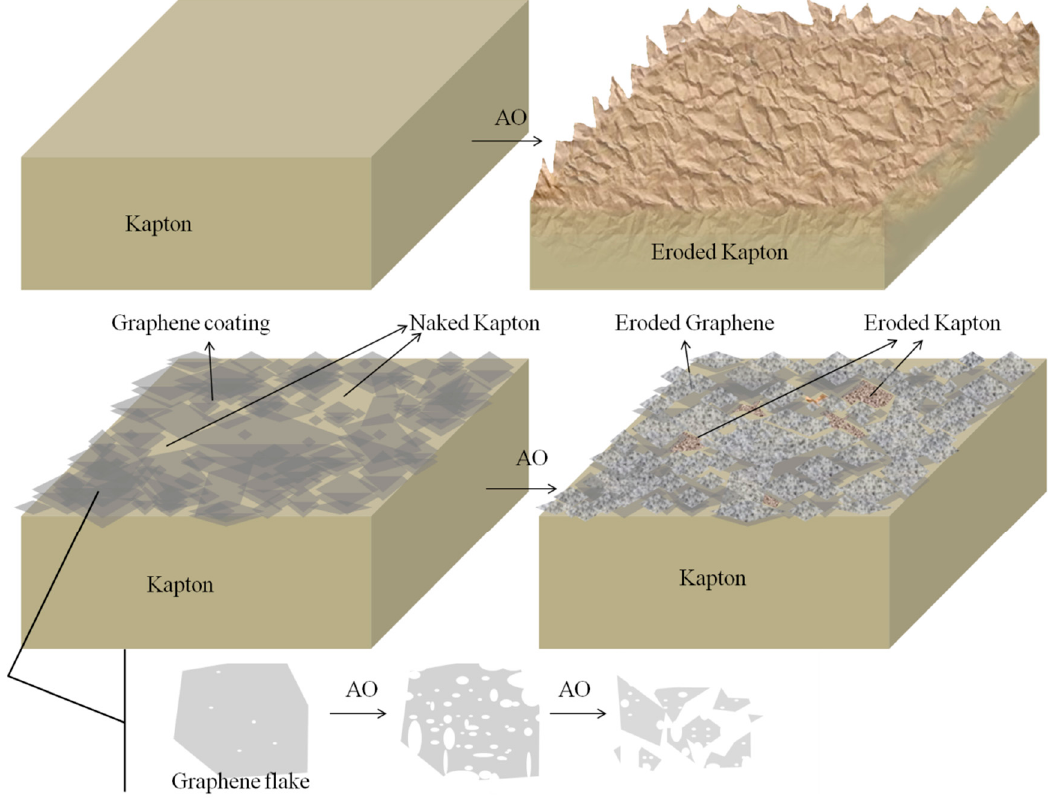
Figure 12. Schematic of the mechanism that graphene coating protect Kapton from AO erosion.